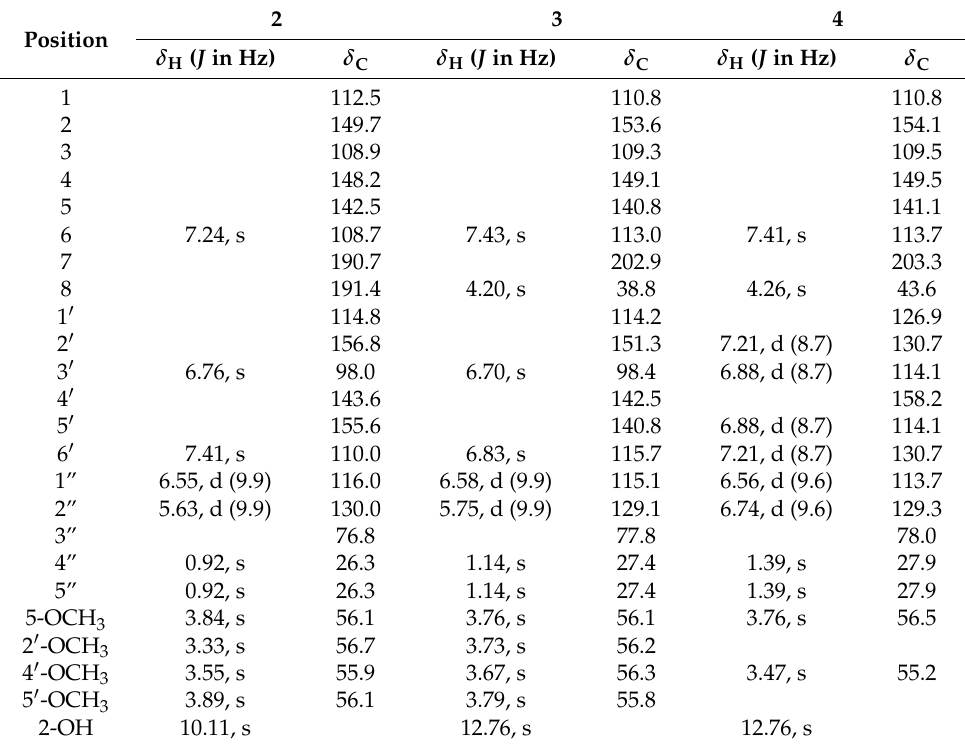
Table 2. 1 H (600 MHz) and 13 C (125 MHz) NMR spectroscopic data of 2 – 4 recorded in DMSO- d 6 ( δ in